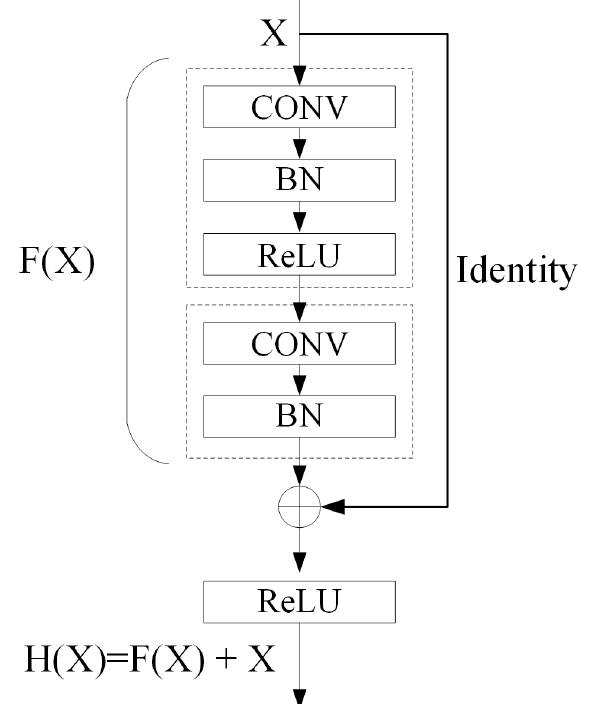
Figure 5. The residual block structure.